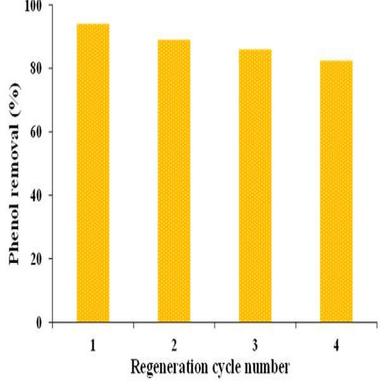
Phenol removal (%) after the regeneration of nZVI@ACh adsorbent with NaOH.